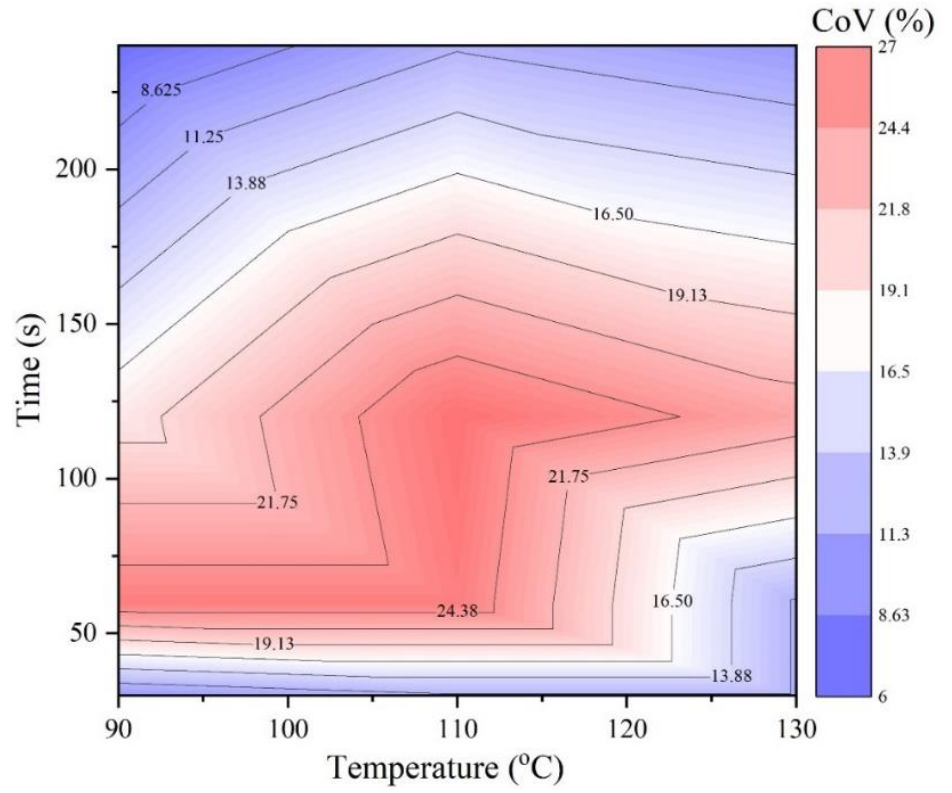
Figure 10. The stiffness variation caused by mixing time and mixing temperature.